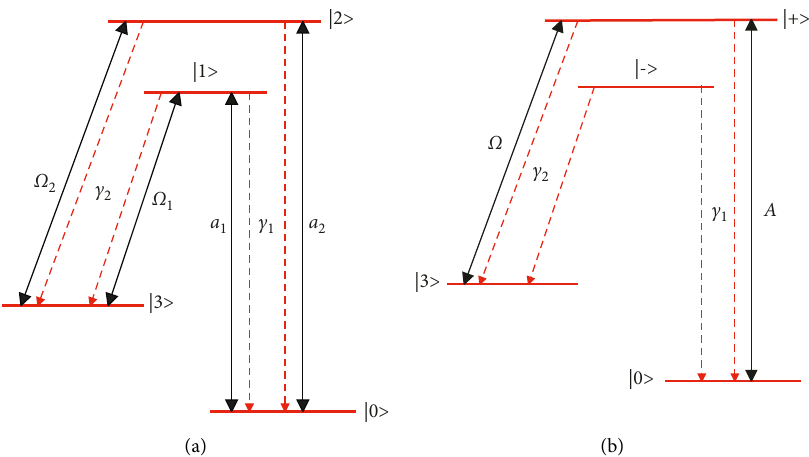
Figure 3: (a) Schematic diagram of the interaction between the audio and field of coherently driven quantum beat audio and (b) the equivalent audio and field interaction diagram in the decorated state of the microwave field.